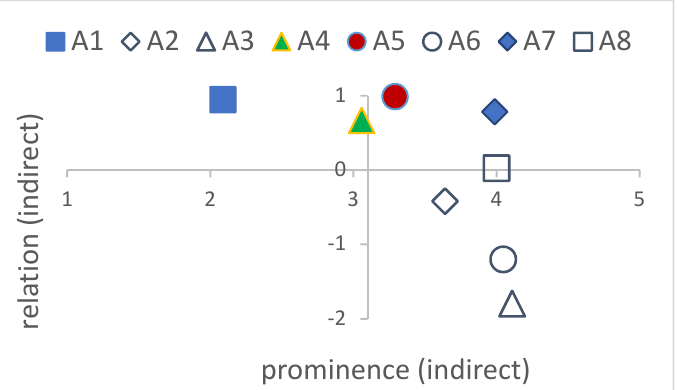
Figure 5. Results for the full set of factors; the indirect influence Δ X case.